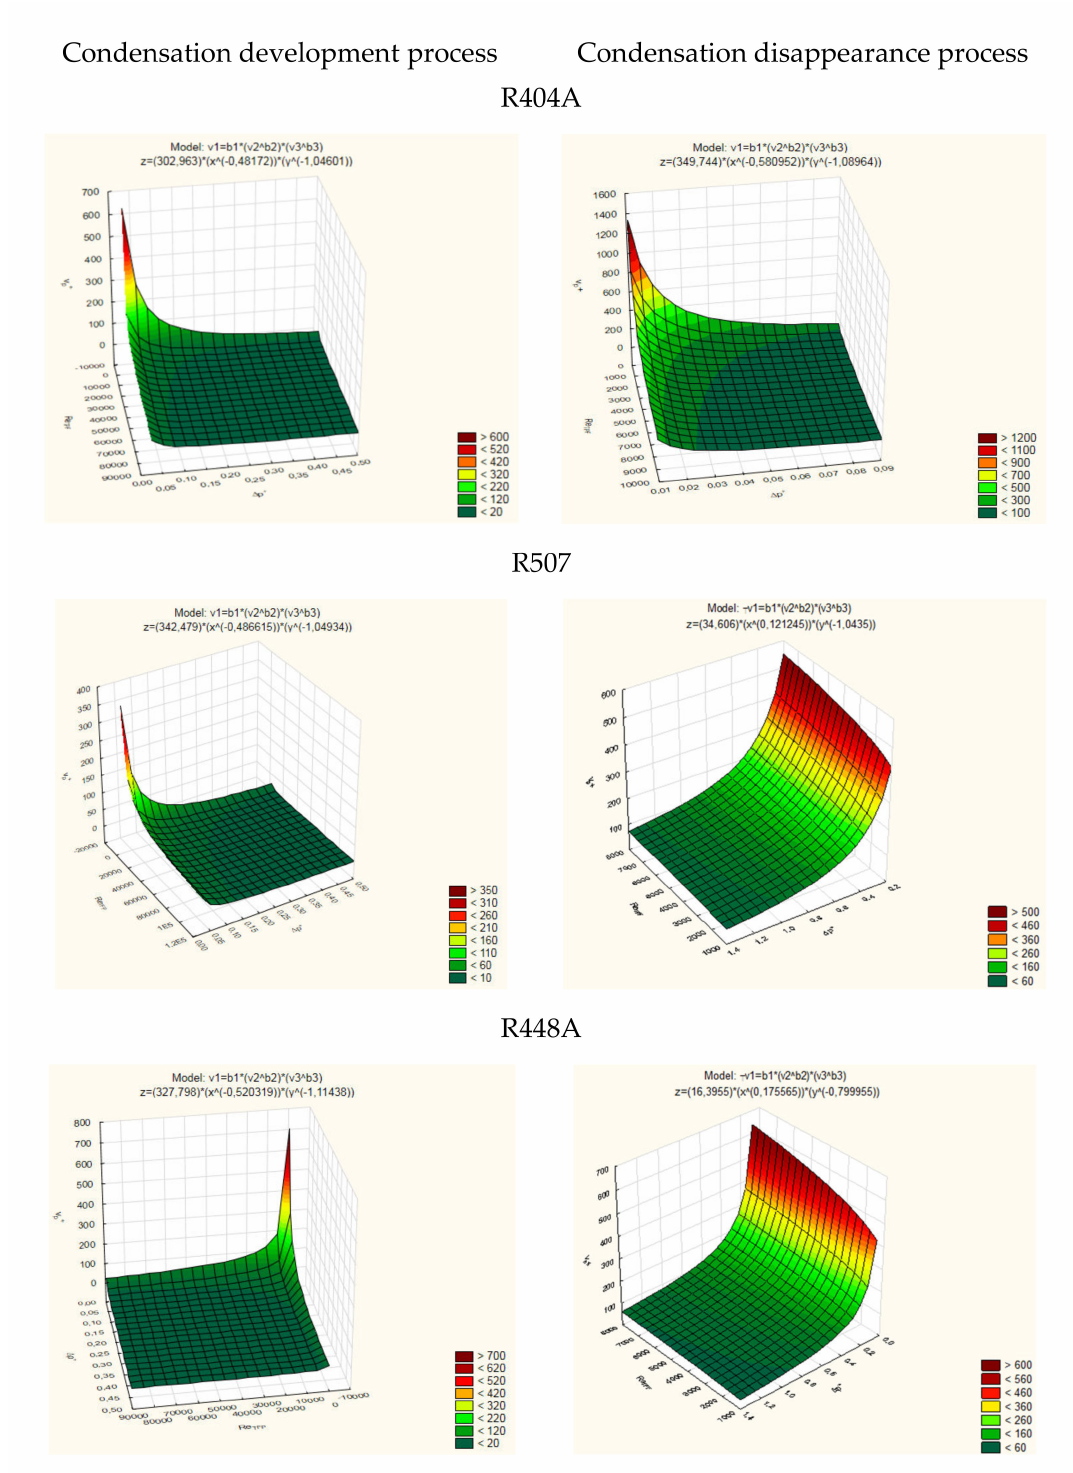
Figure 5. Scope of the compliance of the calculated and experimental results for the σ 2 variance and r-Pearson significance coefficients of the investigated R404A, R507 and R448A refrigerants, for the dimensionless propagation velocity of pressure instabilities v + p , the calculations made with Statistica